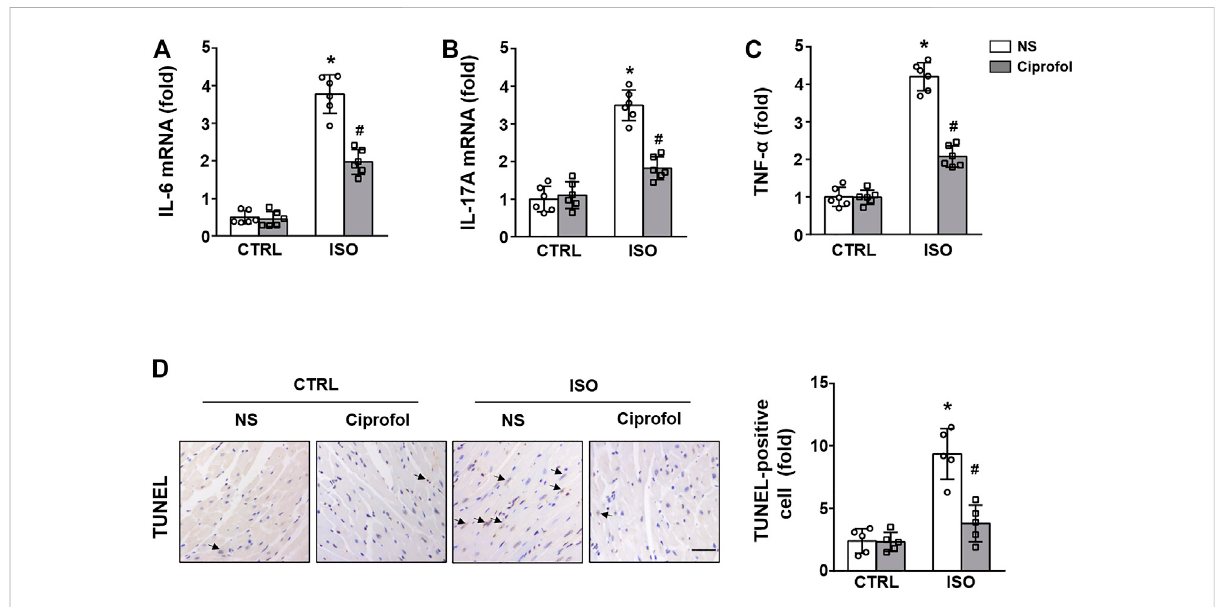
FIGURE 4 Ciprofol treatment inhibited ISO-induced in fl ammation and cardiomyocyte apoptosis. The mRNA levels of IL-6 (A) , IL-17A (B) and TNF- α (C) were measured ( n = 6). (D) Representative images of TUNEL staining in each group ( n = 5). p p < 0.05 compared to the CTRL group. # p < 0.05 compared to the ISO group.